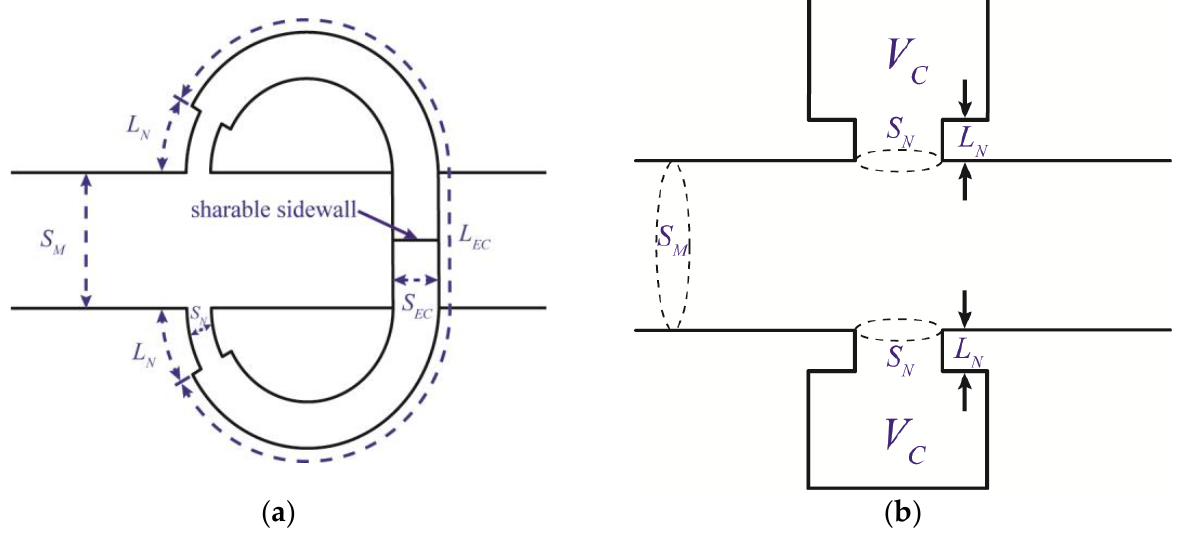
Figure 5. Configuration of curved HRs and parallel HRs systems. ( a ) Curved HRs; ( b ) parallel HRs.